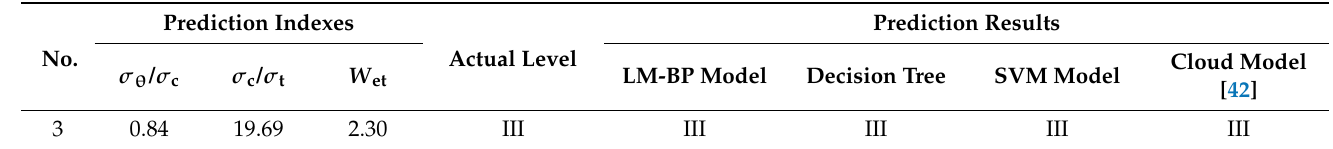
Table 8. Rockburst data and prediction results of Jinping II hydropower station.